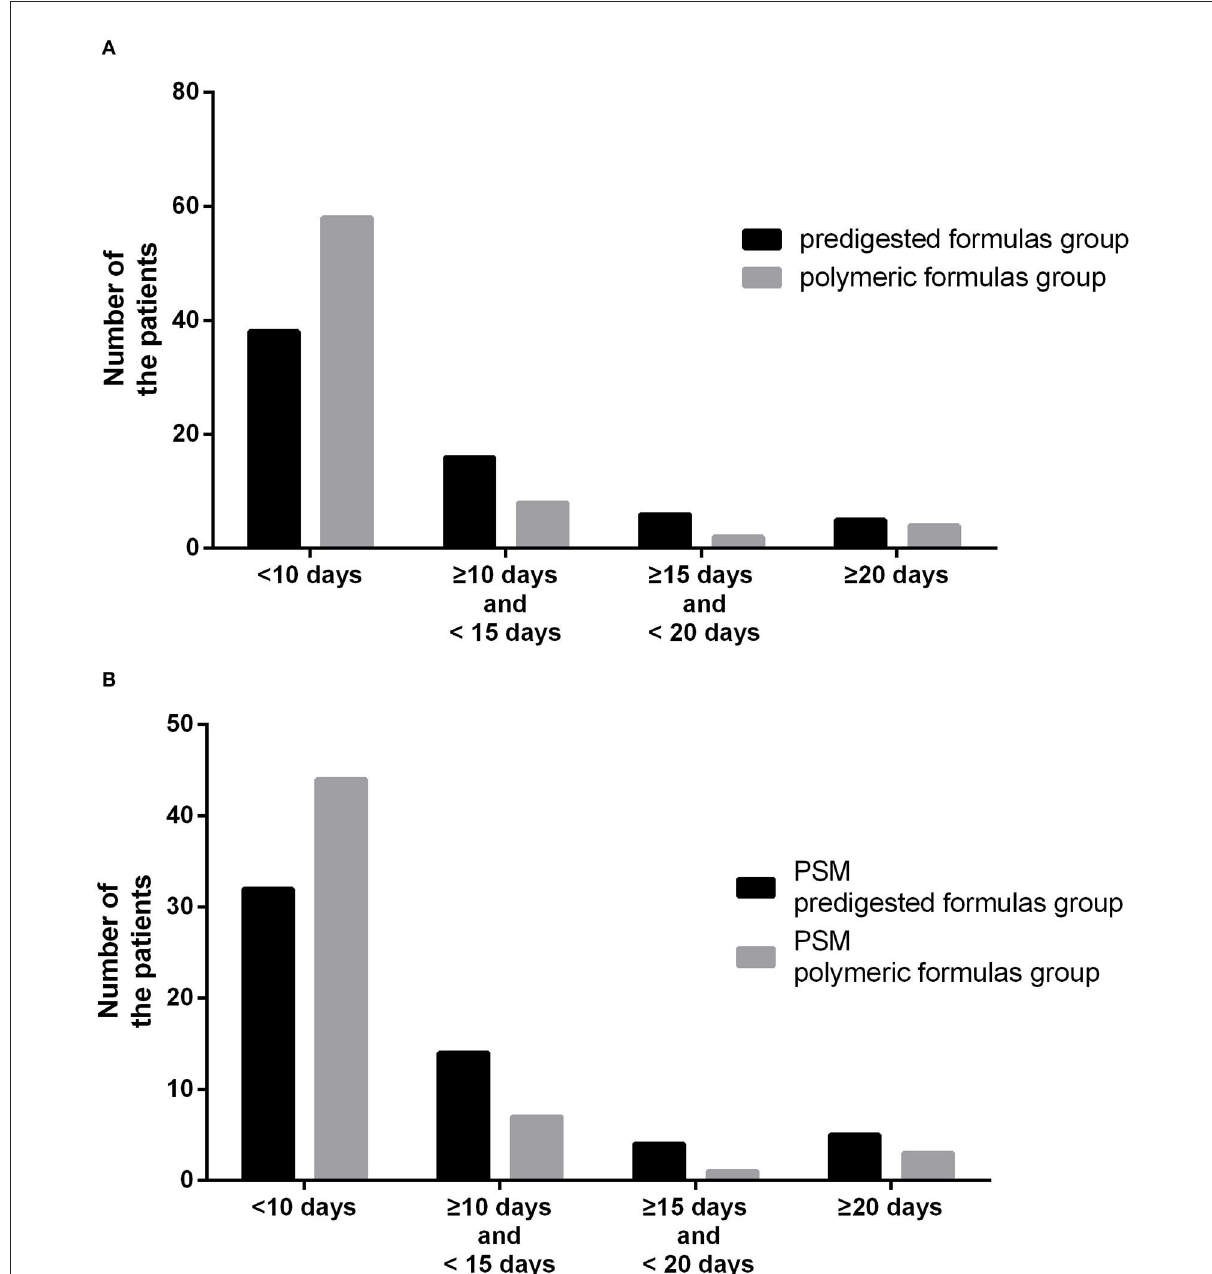
FIGURE2 (A) Number of patients with different defecation times between the predigested formula group and polymeric formula group. (B) Number of patients with different defecation times between the PSM predigested formula group and PSM polymeric formula